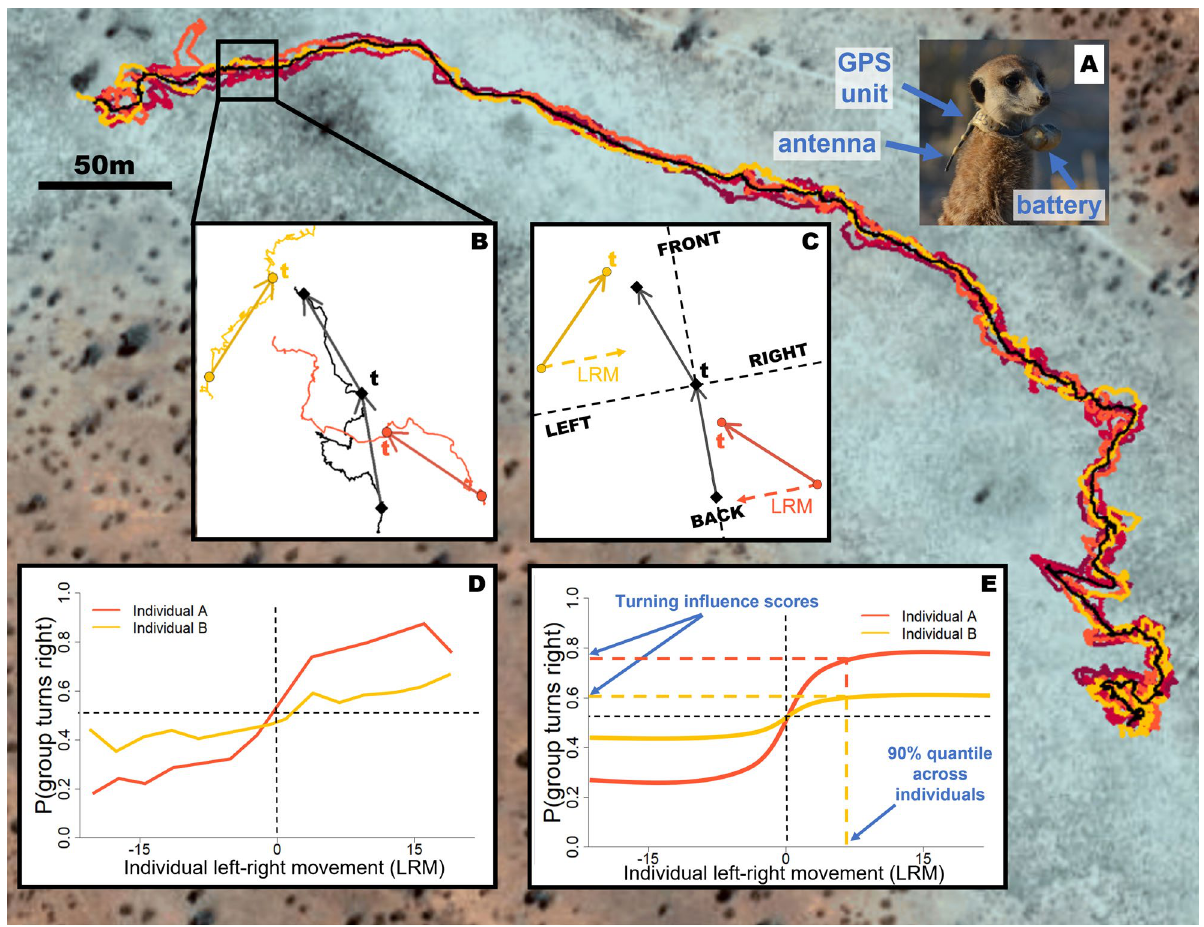
Figure 1. Summary of the data processing pipeline to calculate the turn influence scores of each individual. Background image shows the trajectories of six meerkats from group HM17 recorded over a 3-h time period at 1 Hz using GPS collars. The black line represents the trajectory of the group centroid over the same time- interval, obtained by averaging the coordinates of every individual in the group at each time step. ( A ) Photo of a meerkat wearing a GPS collar. ( B ) Close up of a portion of the trajectory, with only the group centroid and two individuals shown, in yellow and orange, for clarity. At a given time t , velocity vectors (solid arrows) are calculated for the past and future movement of the group (black arrows) and individual (colored arrows) using spatial discretization. ( C ) The centroid’s past velocity vector is used to define a group reference frame (dashed lines) relative to which the position and movement of individuals are calculated. Based on the centroid’s future velocity vector, the group is defined as either turning left or turning right at time t (turning left in the example). An individual’s left–right movement (LRM, dashed arrows) is calculated as the component of its past velocity vector along the left–right axis of the group reference frame. In this example, the orange individual has a positive turn influence at time t because it was moving toward the left side of the group before the group turned left. Conversely, the yellow individual has a negative turn influence at time t because it was moving toward the right side of the group before the group turned left. ( D ) After aggregating data across all time steps, the probability of the group to turn right as a function of an individual’s left–right speed can be estimated. Exploratory analyses showed that this curve typically shows a sigmoid-like shape: as an individual moves faster toward the right, the probability of the group to turn right in the future increases (and correspondingly for the probability of turning left). However, the extent and steepness of this increase varies for different individuals, which we interpret as differences in influence . Here, the orange individual has a higher influence on the rest of the group than the yellow individual (steeper curve). ( E ) We model these influence curves using a modified logistic function, and the 90% quantile of the left–right movement across all individuals of a given group is used to compute a single turn influence score for each individual. The speed influence score is calculated analogously, using instead the probability of the group to speed up as the response variable and the difference between group and individual front-back speed as the predictor variable (not shown, see main text). Note that in the real analyses, the data for a given individual whose influence is being measured is excluded from the computation of the centroid location and movement, to avoid circularity. See Supplemental Materials Sect. 1c for a more detailed description of the